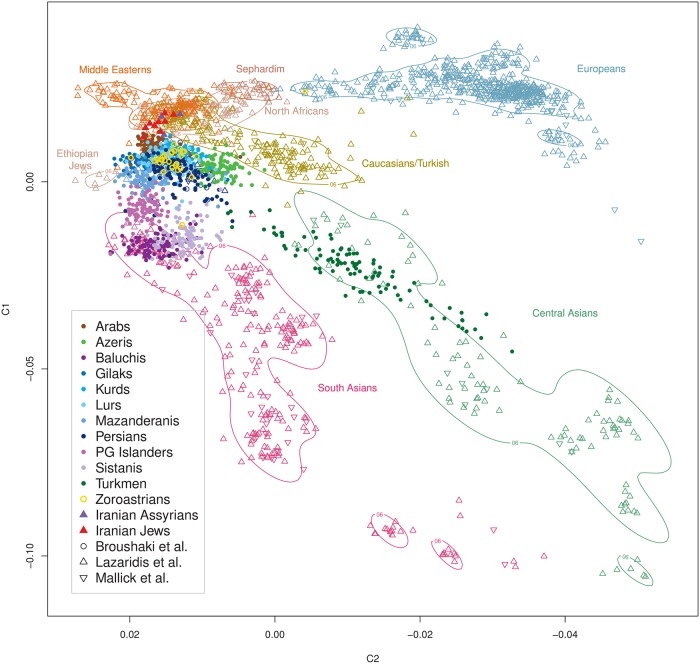
Iranian ethnic groups in a regional context.Relative sample locations with respect to the first two MDS components. Iranian ethnic groups (solid points) in a local context of samples from [2, 6, 44] (open symbols, triangles and 90% density limits).